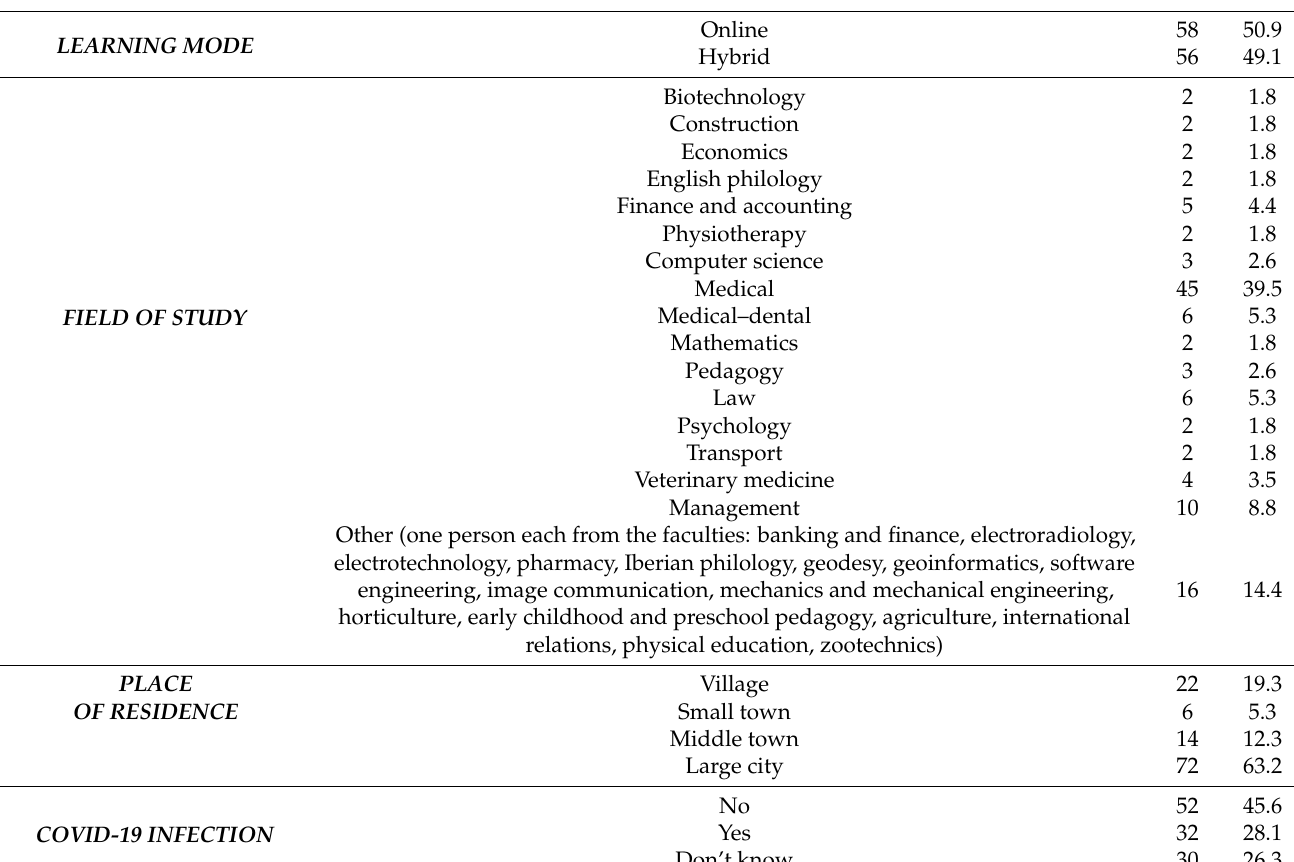
Table 1. Demographic characteristics of participants ( n =